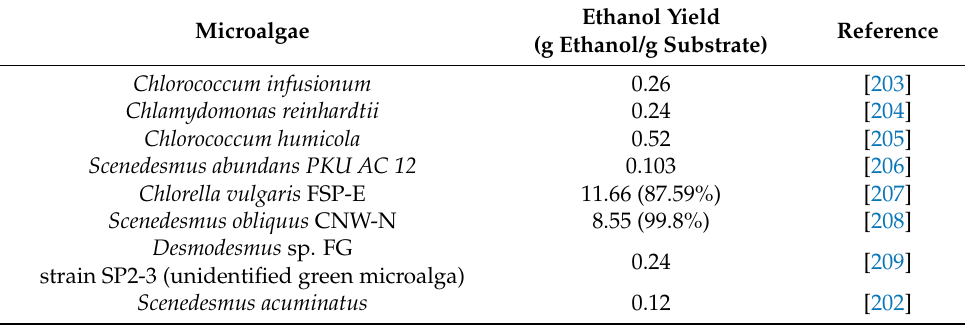
Table 6. Bioethanol production from various microalgae